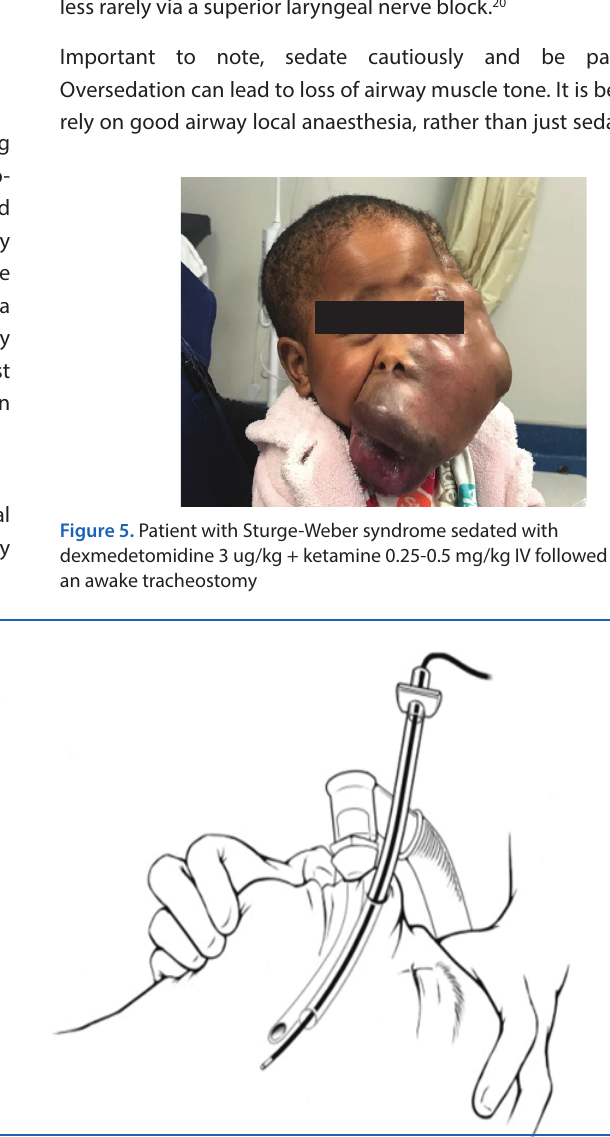
Figure 4. Modified Nasal Trumpet manoeuvre 25 – controlled or assisted ventilation through the right nostril (with other orifices firmly occluded) while the other nostril is used for intubation via a fibreoptic scope